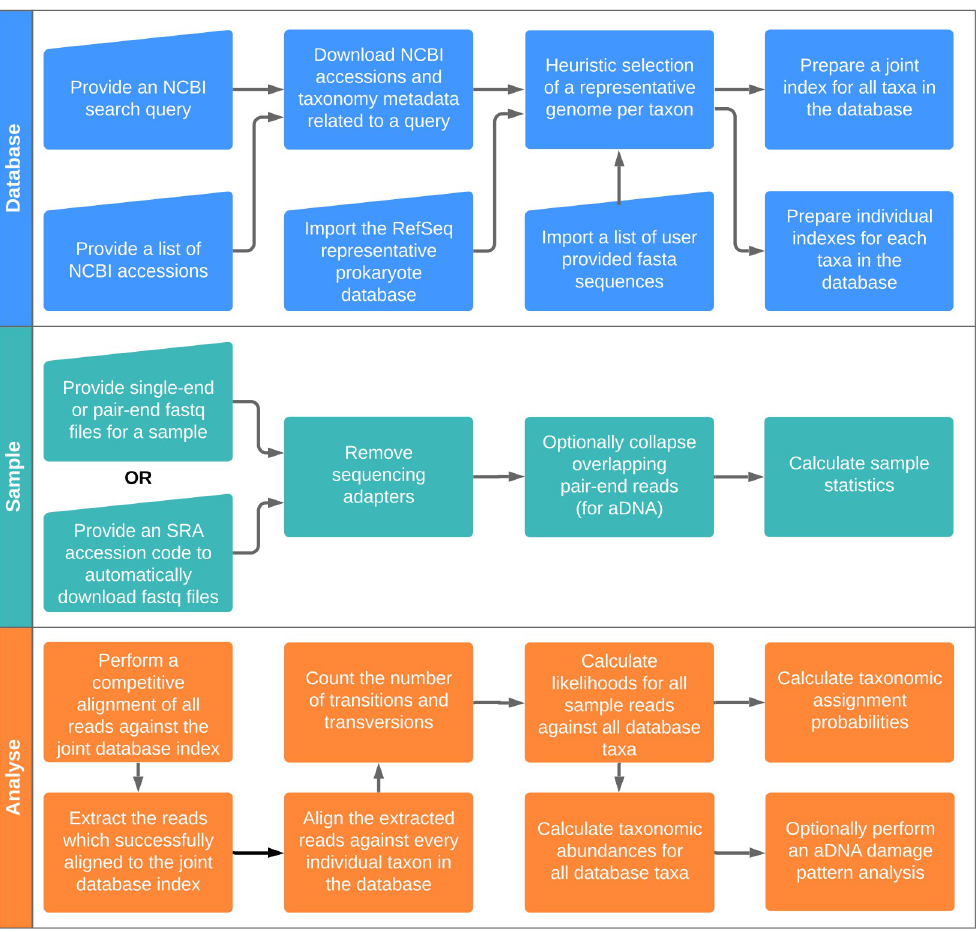
Fig 1. HAYSTAC’s workflow. HAYSTAC consists of three main modules: (i) DATABASE, which builds a database of reference genomes from various user input sources; (ii) SAMPLE, which handles downloading sequencing files from the SRA and pre-processing of samples prior to analysis; and (iii) ANALYSE, which performs an analysis of a sample against a database by applying the mathematical model (see methods) for taxonomic abundance